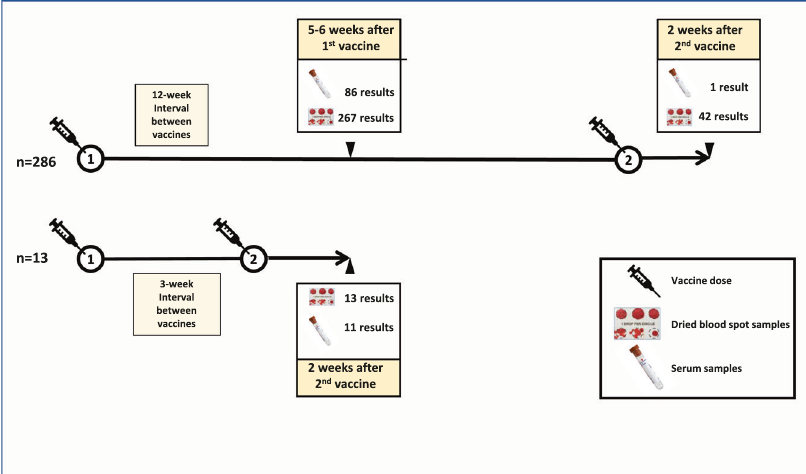
Fig. 1 Infographic of study design and collection. Samples were collected from patients who had undergone dual vaccination with either an ‘ extended interval ’ ( n = 286) or ‘ standard interval ’ regimen ( n = 13). Antibody levels in serum samples obtained by phlebotomy or in eluates from dried blood spot samples were assessed at the indicated